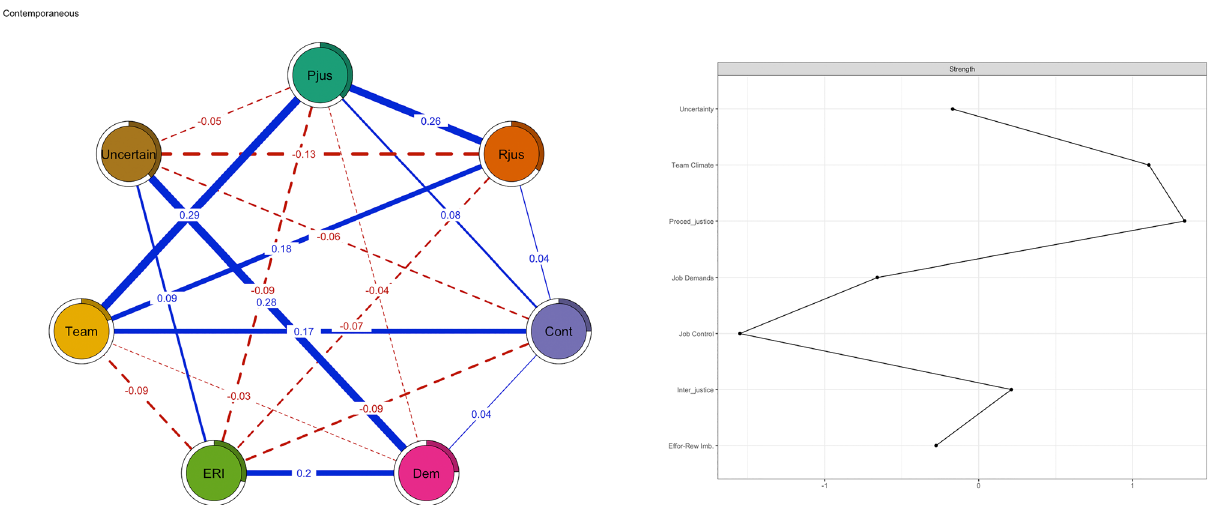
Figure 4. Contemporaneous relations between psychosocial factors (procedural justice = pjus, interactional justice = rjus, effort-reward imbalance = eri, job demands = dem, job control = cont, uncertainty = uncer, team climate =